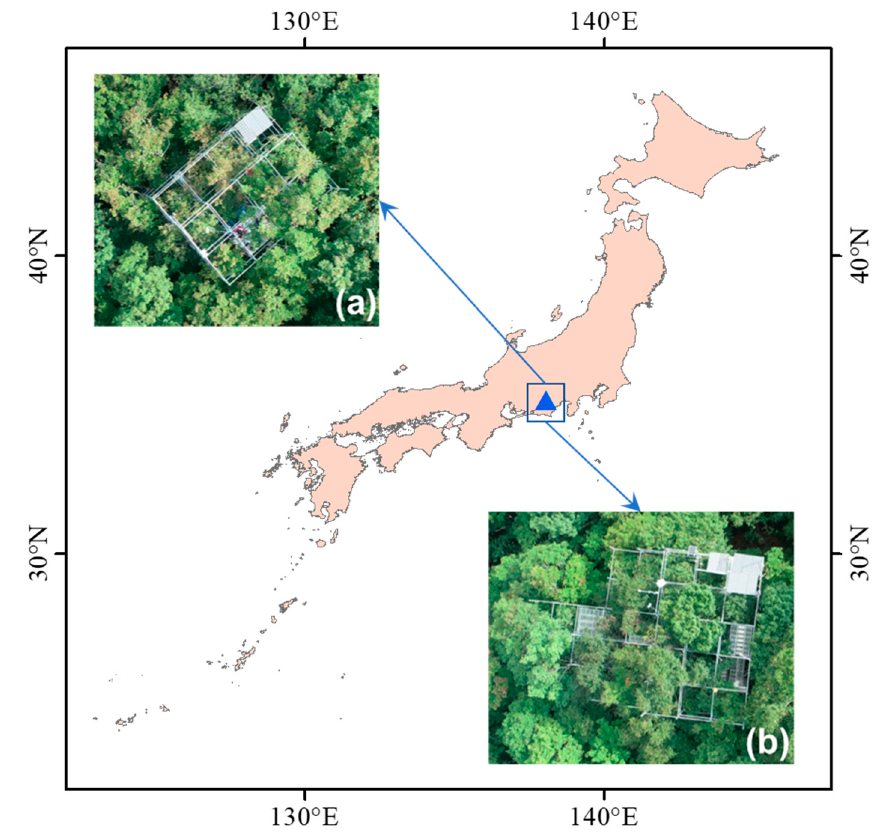
Figure 1. Study site location: ( a ) north tower, and ( b ) south tower.